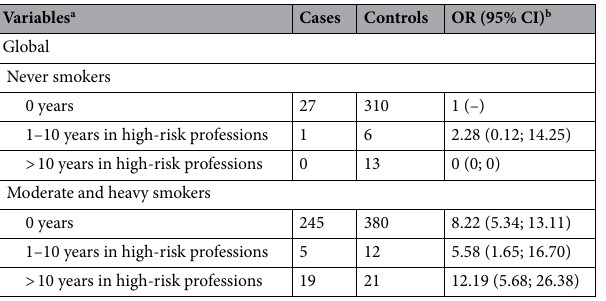
Table 3. Small cell lung cancer risk stratified by tobacco consumption. a Missing information for 126 cases and 163 controls. b Adjusted by sex and indoor radon